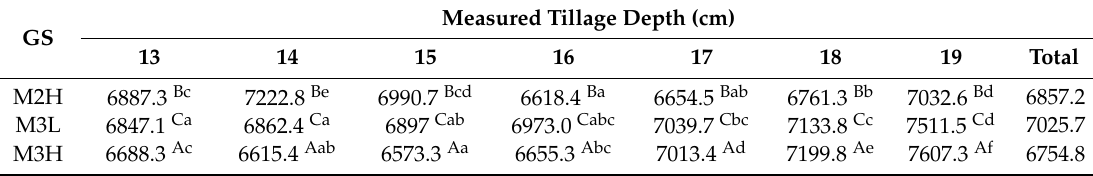
Figure 10. Overall rear axle load according to the tillage depth and gear selections. Table 13. Mean rear axle torque (Nm) according to the tillage depth and gear selection (GS).